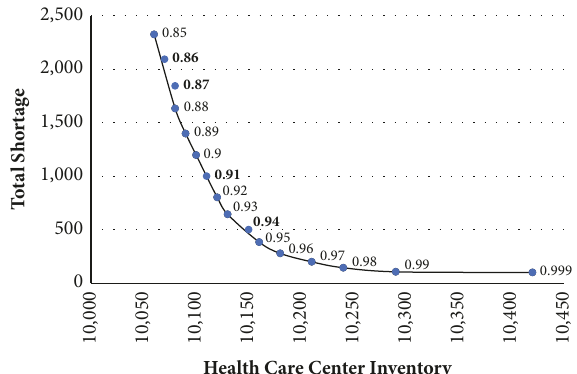
Figure 3: Effects of inventory policies, defined by CSL, on the total shortage and health center inventory and an estimate of the efficient frontier defining nondominated inventory policies. The CSLs equal to.86, .87, .91, and .94 are inefficientand not included on theefficient